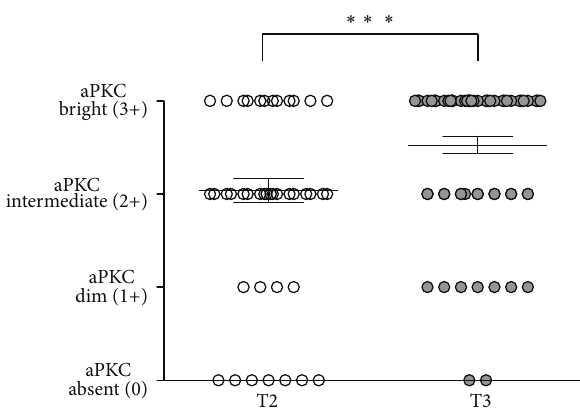
Figure 4: Correlation of aPKC staining intensity with tumor stage. Distribution of aPKC staining intensity in prostate cancer at different tumor stages (T). ∗∗∗ 𝑃 < 0.001 , Chi-square test. Overall, aPKC score correlated with T, Chi-square test, 𝑃 < 0.01